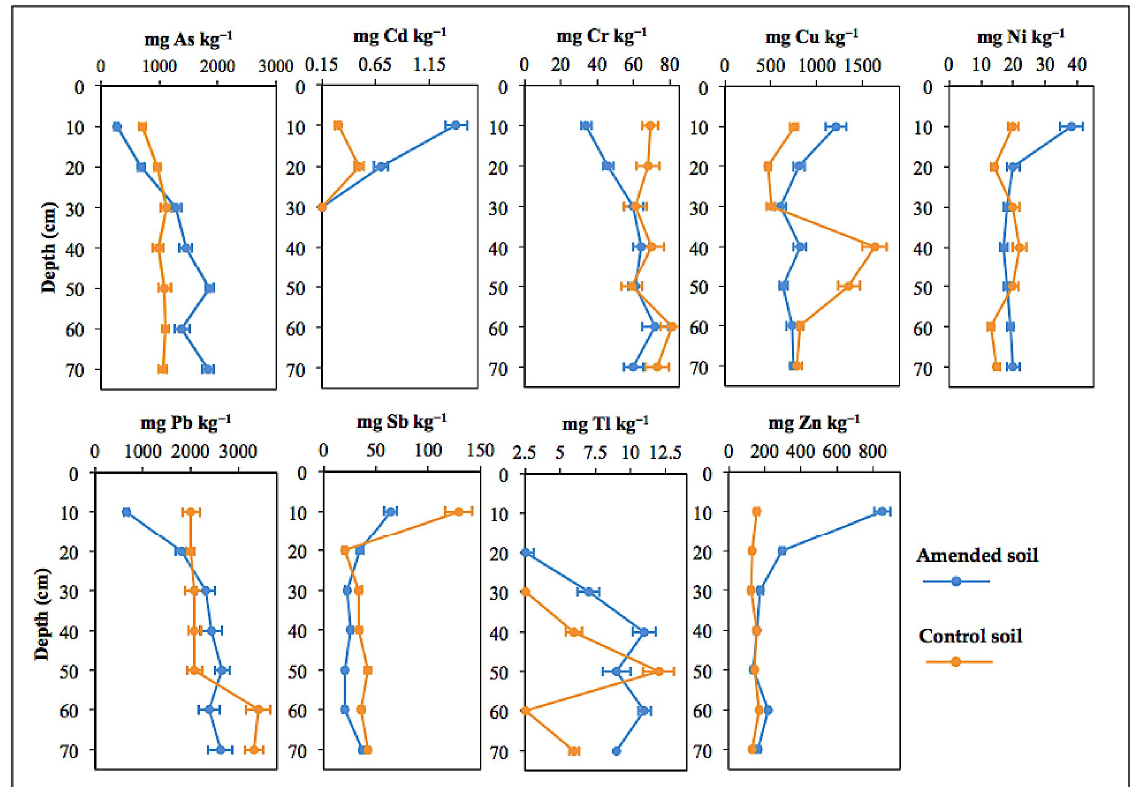
Figure 4. Vertical distribution of trace elements along the two sampling sections (amended and control) of the soil profile.